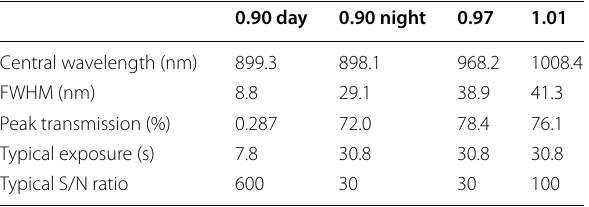
Table 1 Characteristics of the four channels of the 1‑μm